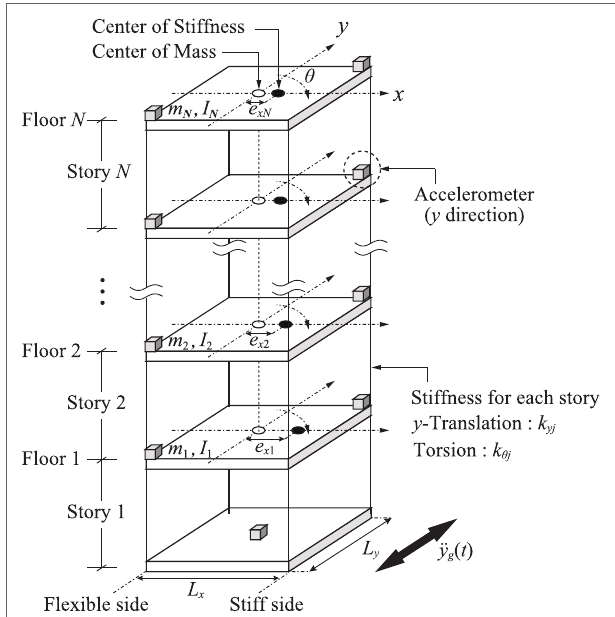
FIGURE 1 | Three-dimensional multi-story building structure model with stiffness eccentricity subjected to unidirectional earthquake ground motion and allocation of